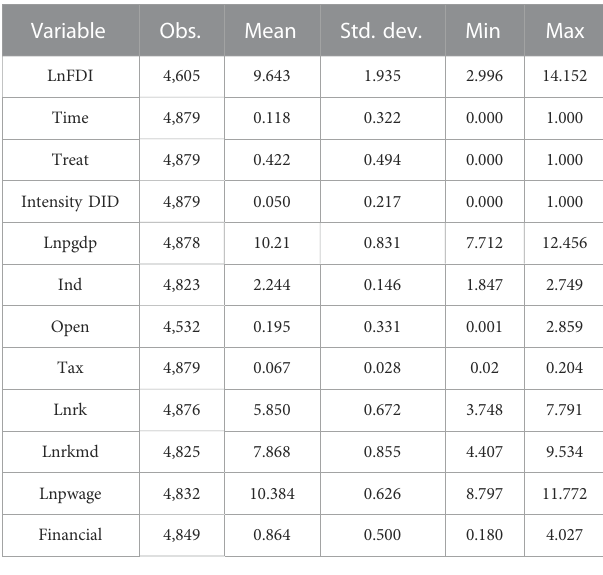
TABLE 2 Descriptive